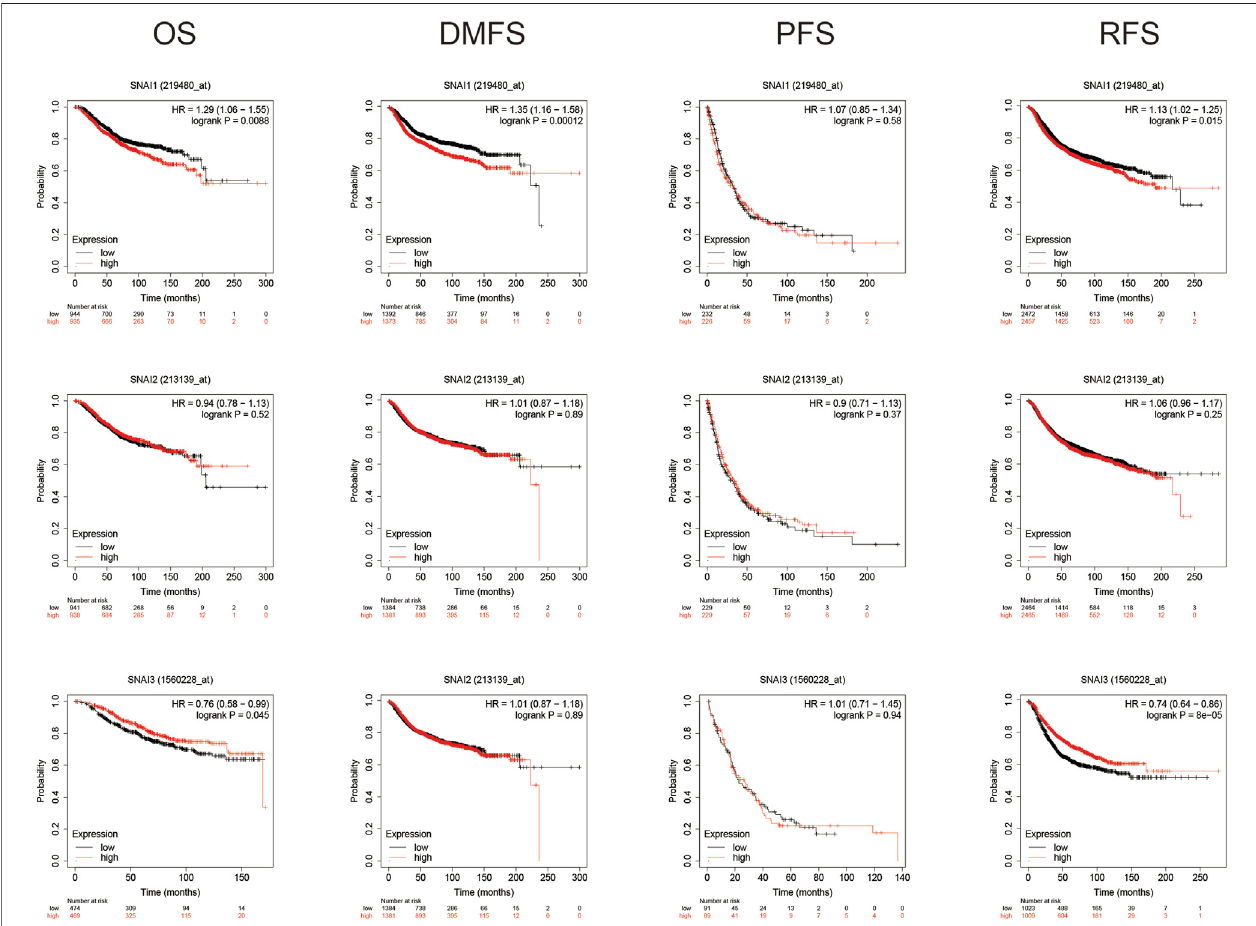
FIGURE 3 | Prognostic value of SNAI transcript levels in breast cancer patients. Breast cancer patients were classi fi ed into two groups based on the median expression levels of SNAI1 , SNAI2 , or SNAI3 . Overall survival (OS), distant metastasis-free survival (DMFS), progression-free survival (PFS), and relapse-free survival (RFS) were compared between patients with high SNAI expression and those with low SNAI